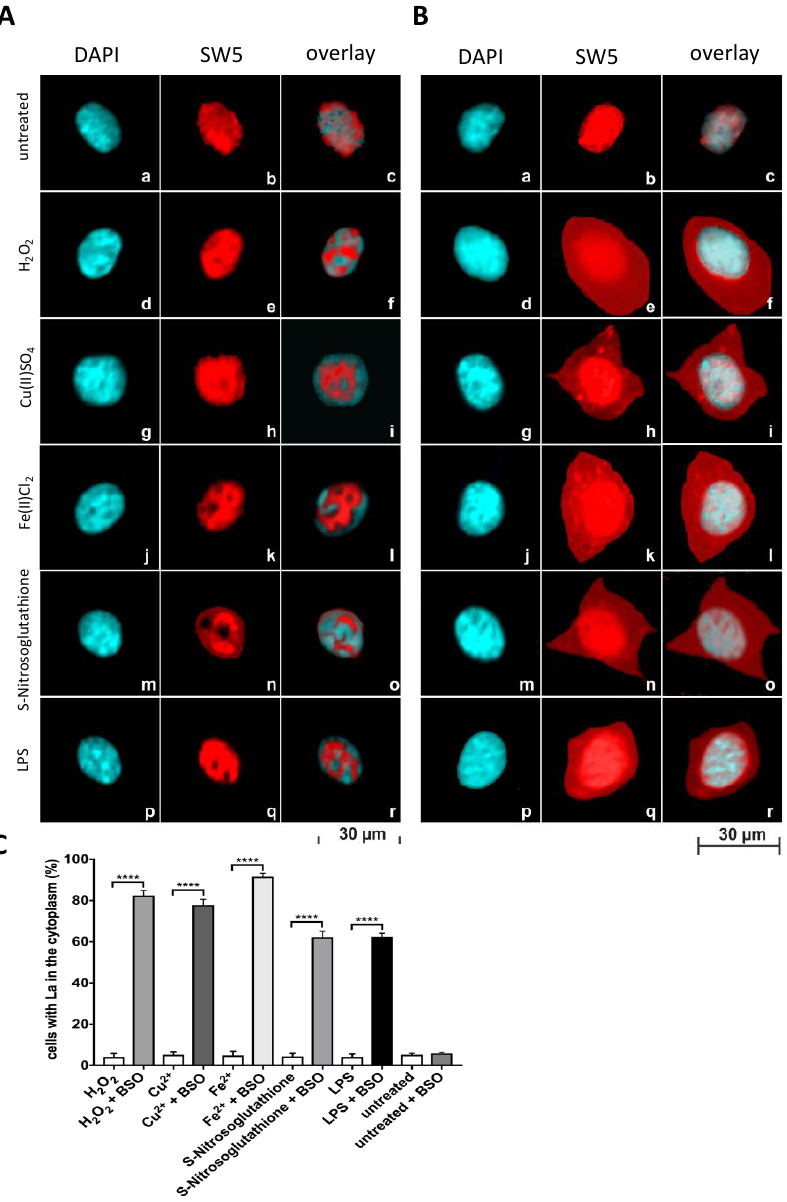
Figure 7. Shuttling of La protein in human umbilical vein endothelial cells (HUVEC). ( A,B ) HUVECs grown in the absence ( A ) or presence ( B ) of buthionine-sulfoximine (BSO). HUVECs were stained with DAPI ( a , d , g , j , m , p ) or the anti-La mAb SW5 ( b , e , h , k , n , q ). Overlay of both channels is shown in addition ( c , f , i , l , o , r ). ( a – c ) Untreated cells. ( d – f ) Cells treated with H 2 O 2 . ( g – i ) Cells treated with Cu(II)SO 4 . ( j – l ) Cells treated with Fe(II)Cl 2 . ( m – o ) Cells treated with S-Nitrosoglutathione. ( j – l ) Cells treated with LPS. ( C ) Quantitative evaluation. p Value < 0.0001 = ****.